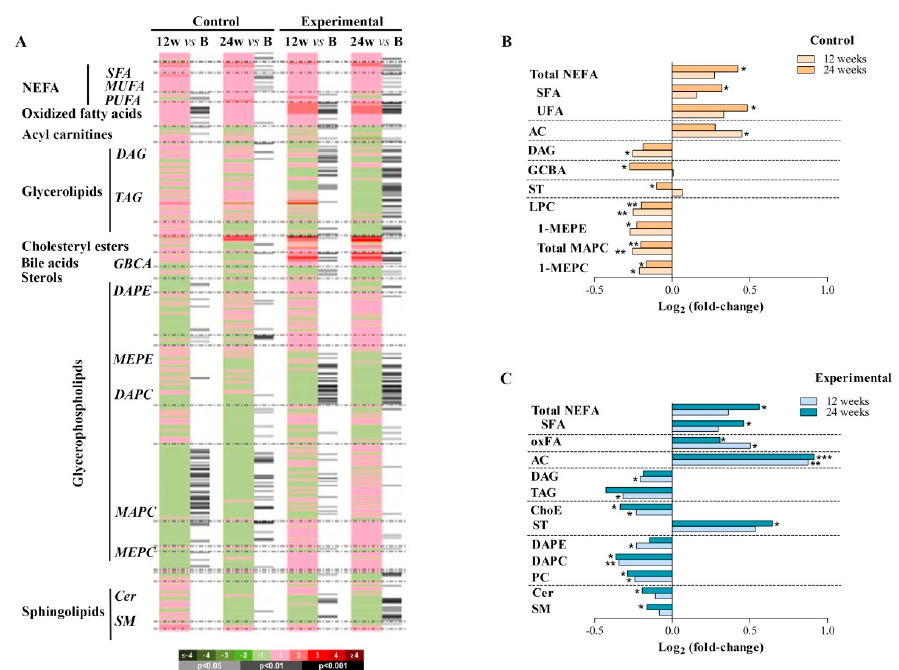
Figure 3. Effect of EFV and RPV on lipid metabolism. ( A ) Heatmap representing individual metabolic features obtained from the comparisons between the groups at 12 and 24 weeks after ART randomization. ( B, C ) Highlighted metabolite changes from the heatmap found at 12 and 24 weeks compared to the corresponding baseline values in patients on EFV ( B ) and RPV ( C ) in the ART. Heatmap colour codes for log2 (fold change) and paired Student’s t-test p -values are indicated on the bottom of the figure. Abbreviations: AC, acyl carnitines; B, baseline; Cer, ceramides; ChoE, cholesteryl esters; DAG, diacylglycerol; DAPC,diacylglycerophosphocholine; DAPE,diacylglycerophosphoethanolamine; GCBA, glycine-conjugated bile acid; LPC, lysophosphatidylcholine; MAPC, monoacylglycerophosphocholine; MEPC, monoetherglycerophosphocholine; MEPE, 1-monoetherglycerophosphoethanolamine; MUFA, monounsaturated fatty acid; NEFA, non-esterified fatty acid; oxFA, oxidized fatty acid; PC, phosphatidylcholine; PUFA, polyunsaturated fatty acid; SFA, saturated fatty acid; SM, sphingomyelin; ST, total steroid; TAG, triacylglycerol; UFA, unsaturated fatty